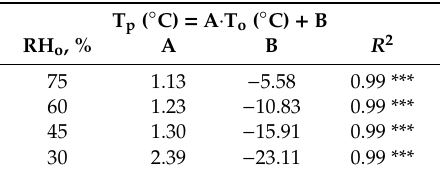
Table 4. Values for the slope (A) and the origin ordinate (B) of the linear regressions between the air temperature at the pad output (T p , °C) and the outside temperature (T o , °C) for different exterior RH values. The determination coefficient value, R 2 , and its statistical significance (***, p < 0.0001) is also indicated.